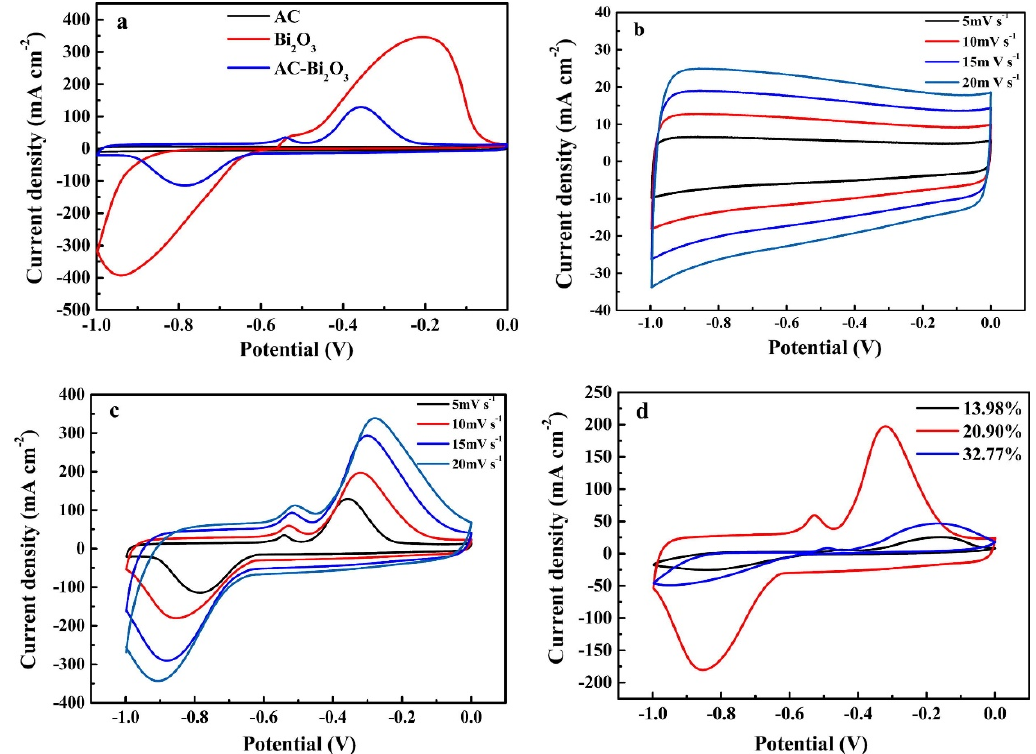
Figure 5. Cyclic voltammogram curves of ( a ) CVs of AC, Bi 2 O 3 and AC-Bi 2 O 3 ; ( b ) CVs of AC at different sweep rates; ( c ) CVs of AC-Bi 2 O 3 at different sweep rates. ( d ) CVs of different contents AC-Bi 2 O 3 composite. Reproduced with permission from ref [62].